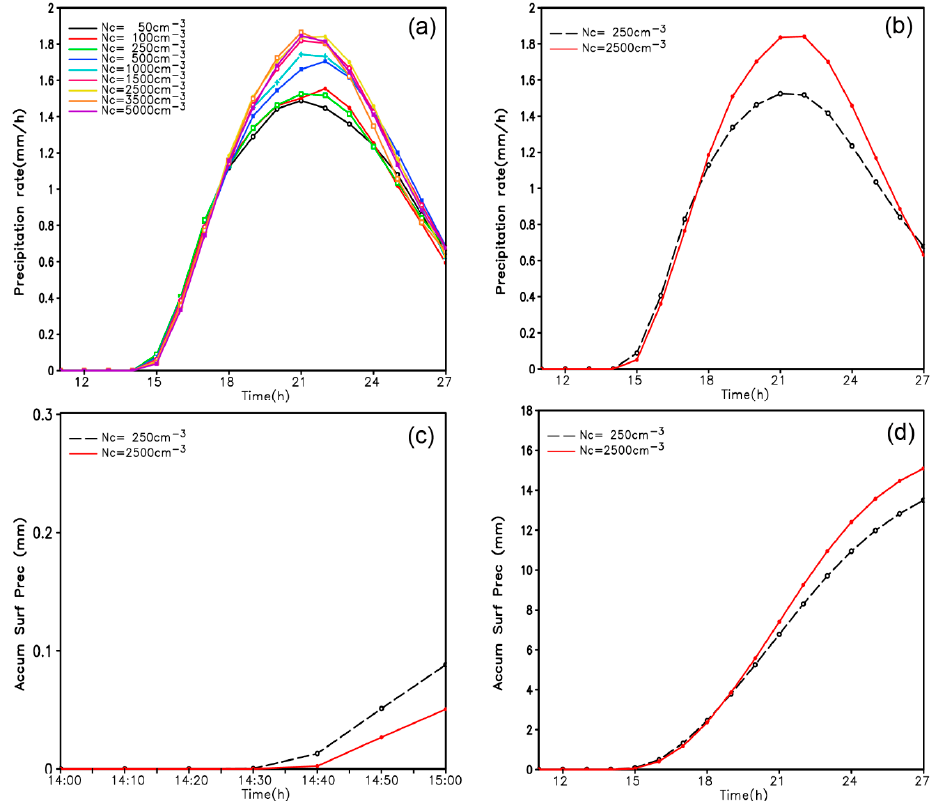
Figure 2. Time series of ( a ) domain-mean surface precipitation rate (mm h − 1 ) in 9 experiments, ( b ) in C-case and P-case only, ( c ) domain-mean accumulated surface precipitation (mm) from t = 14 h to 15 h, and ( d ) domain-mean accumulated surface precipitation before t = 27 h in C-case and